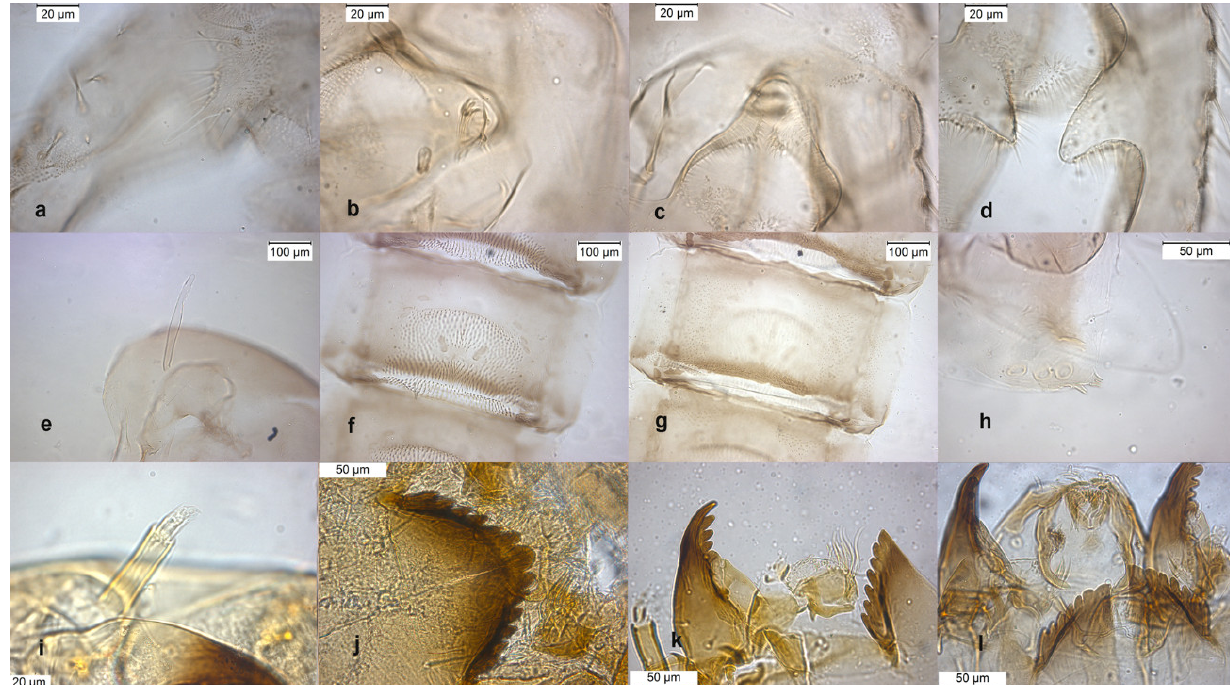
Figure 8. Morphological characters of O. rubicundus adult male: ( a ) anal point; ( b ) virga; ( c ) superior volsella; ( d ) inferior volsella; pupal exuvia: ( e ) thoracic horn, ( f ) tergite IV; ( g ) sternite-IV; ( h ) taeniate extensions; larva: ( i ) antenna; ( j ) mentum; ( k ) mandible; ( l ) labrum.